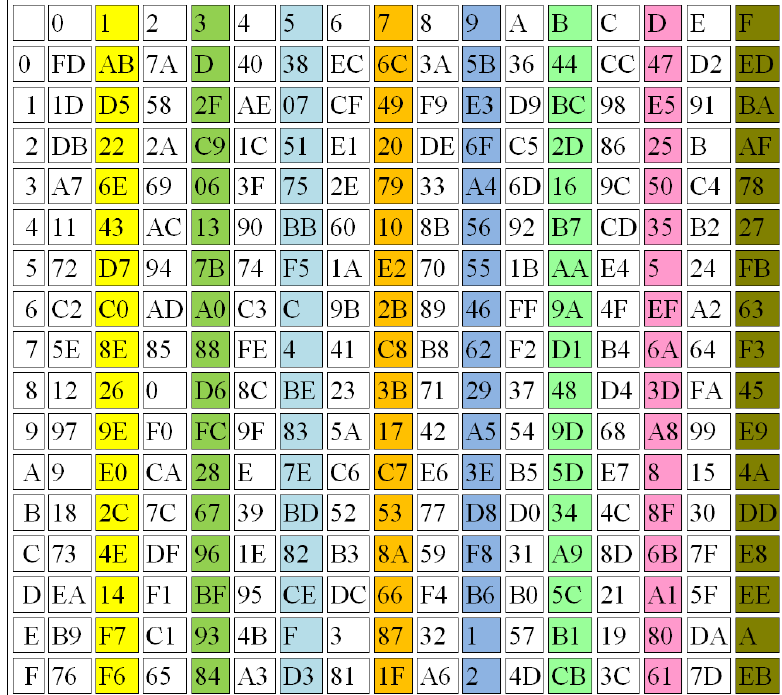
Figure 10. S-BOX2, r = 4.001.